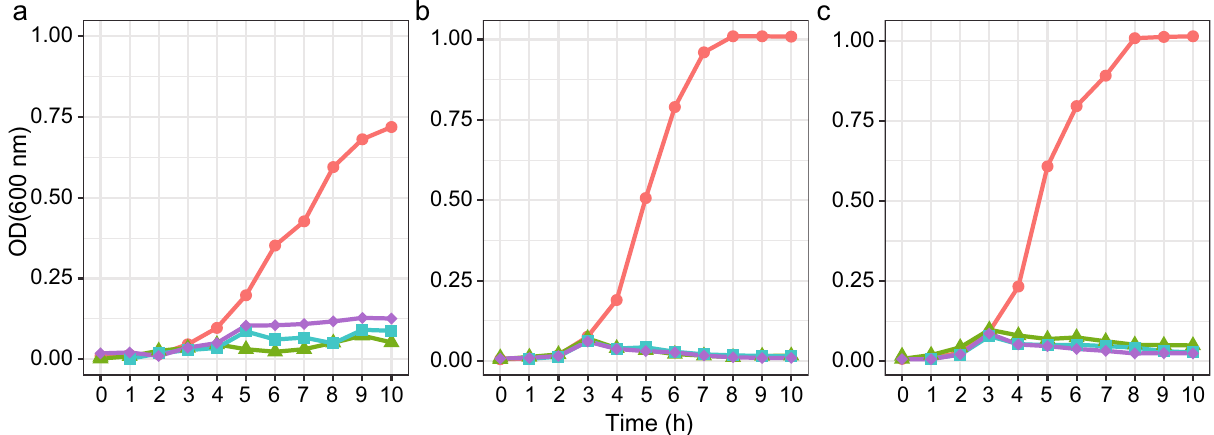
Figure 5. The effect of bacteriocin produced. Bacteriocin produced by Pediococcus acidilactici ST31BZ, Pediococcus pentosaceus ST75BZ and Pediococcus pentosaceus ST87BZ (mean from 3 experiments is shown), on the growth of ( a ). Listeria monocytogenes 104, ( b ) Listeria monocytogenes 637 and ( c ) Listeria monocytogenes 711. Cultures received a standardized bacteirocin dose at 3 h post culture start. Colors indicate the origin of the bacteriocin added: P. acidilactici ST31BZ—green (- ▲ -), P. pentosaceus ST75BZ blue (- ■ -), and P. pentosaceus ST87BZ purple (- ♦ -). Negative control is shown in red (- ●